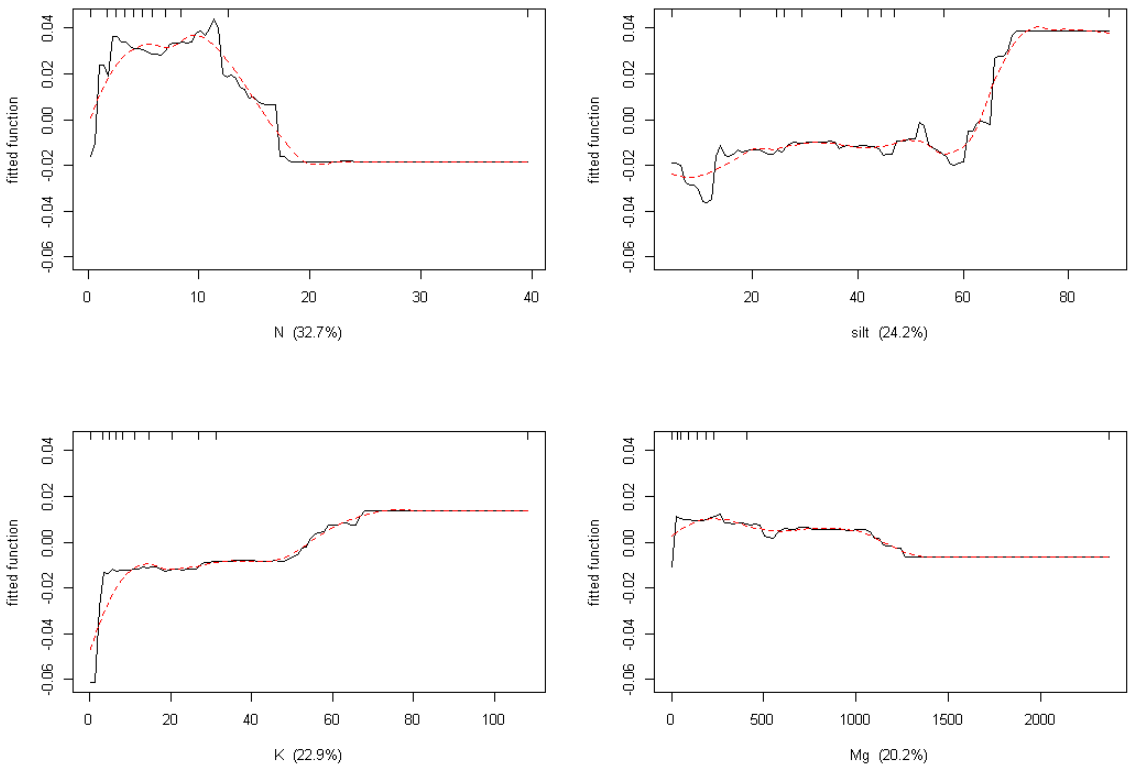
Figure 8. BRT-model of the residuals: effects of N, silt, K and Mg variables on the residuals of the main model (response); the red lines are smoothed response curves; the percentages correspond to the relative importance of the variable.